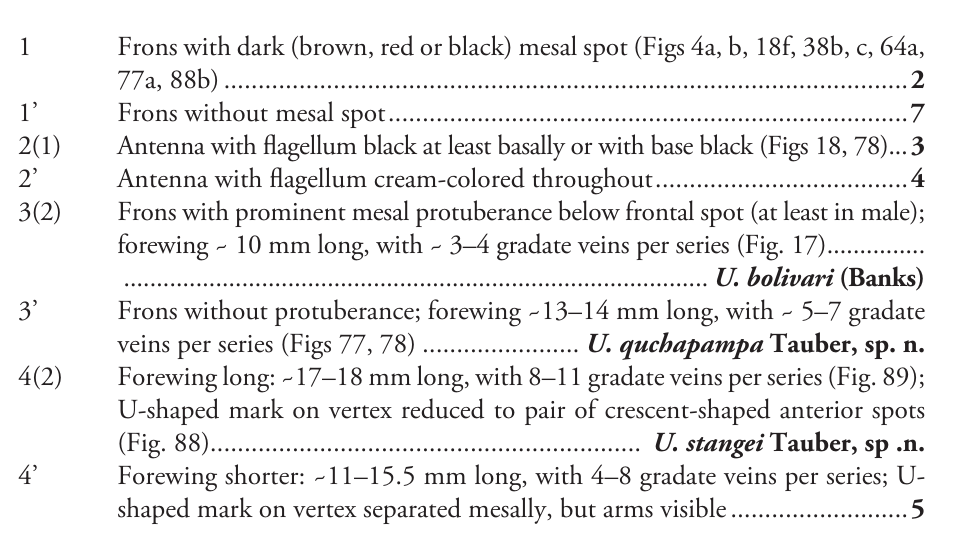
Frons with dark (brown, red or black) mesal spot (Figs 4a, b, 18f, 38b, c, 64a,